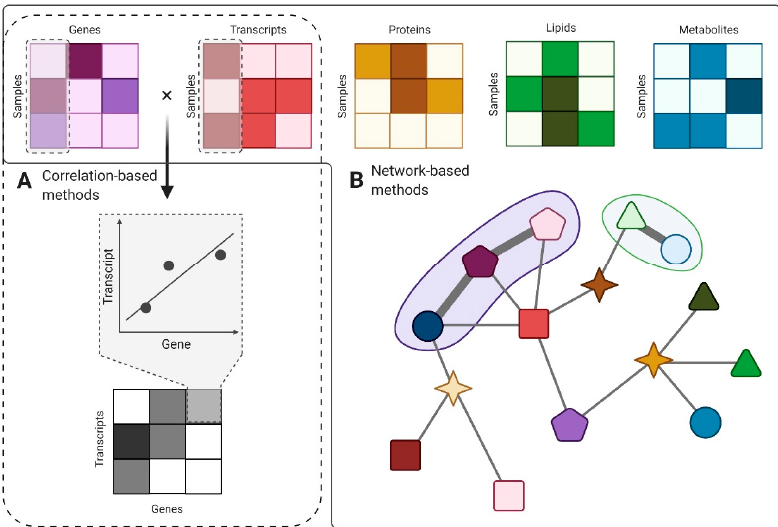
Figure 4. Putative strategy for EV multi-omics data integration. Multi-omics profiles can be observed from a qualitative perspective, accounting for biomolecules preferentially present or absent in certain pathophysiological states, or from a quantitative perspective, accounting for biomolecule abundancies (color gradient) and functional enrichments. Integration of multi-omics data can be achieved using correlation-based methods, a strategy endorsed for a 2 by 2 analysis of omics profiles across samples ( A ), or network-based methods, where the diversity of omics layers can be observed in graph-like structures where biomolecules are nodes and the relationships between them are weighted edges ( B ). The goal of this last approach is to identify functional modules which are activated during EV-mediated cell-to-cell communication. Figure created with